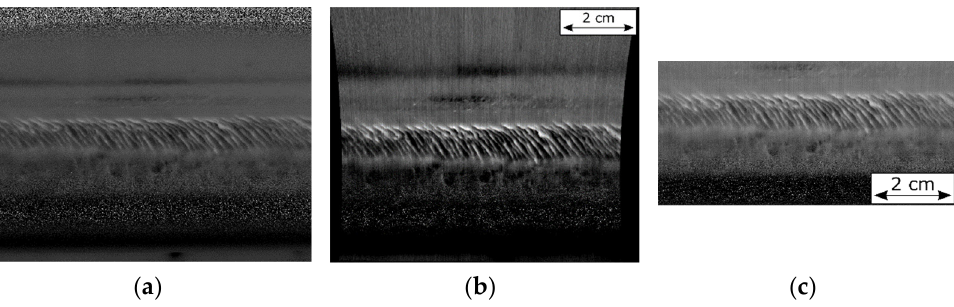
Figure 6. ( a ) Recorded phase image of a segment of the gauge corner; ( b ) phase image after rectification transformation is applied; ( c ) cropped segment of the transformed phase image.